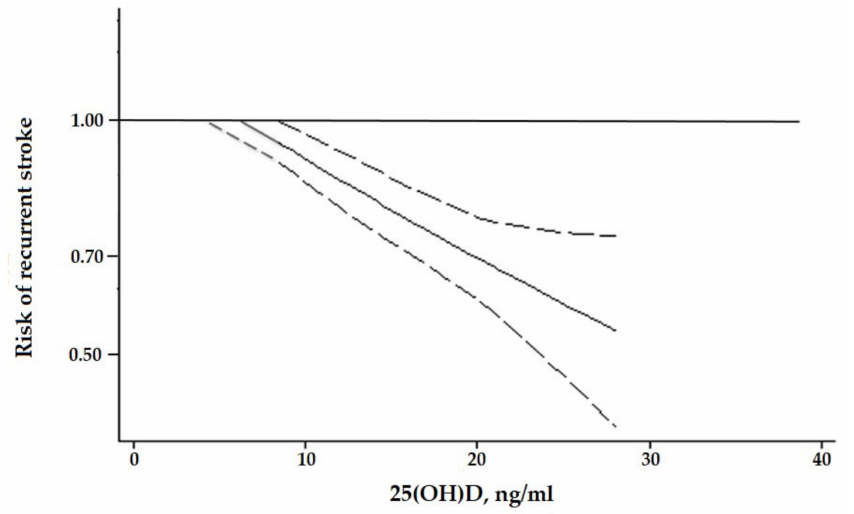
Figure 3. Dose-response association between vitamin D and the risk of stroke recurrence. Here, 25(OH)D: vitamin D serum level. The 25OHD was modelled with restricted cubic splines in a multivariate random-effects dose–response model (solid line). Dashed lines represent the 95% confidence intervals for the spline